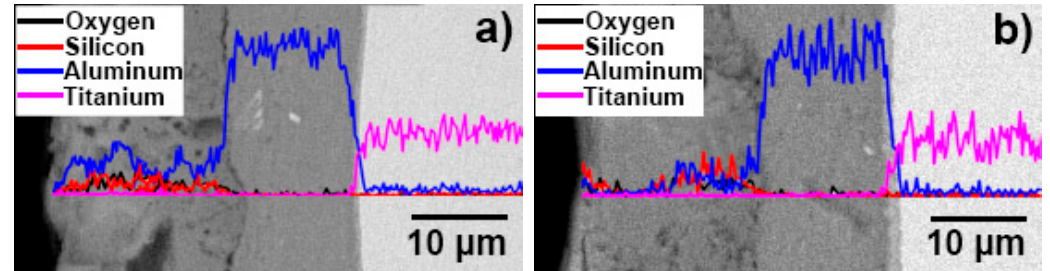
Figure 8. EDS line analysis of aluminium and titanium of the cross ‐ section of the MAO layer formed on TA2 substrate after hot ‐ dip aluminising: ( a ) T ‐ 1 sample, ( b ) T ‐ 2 sample.